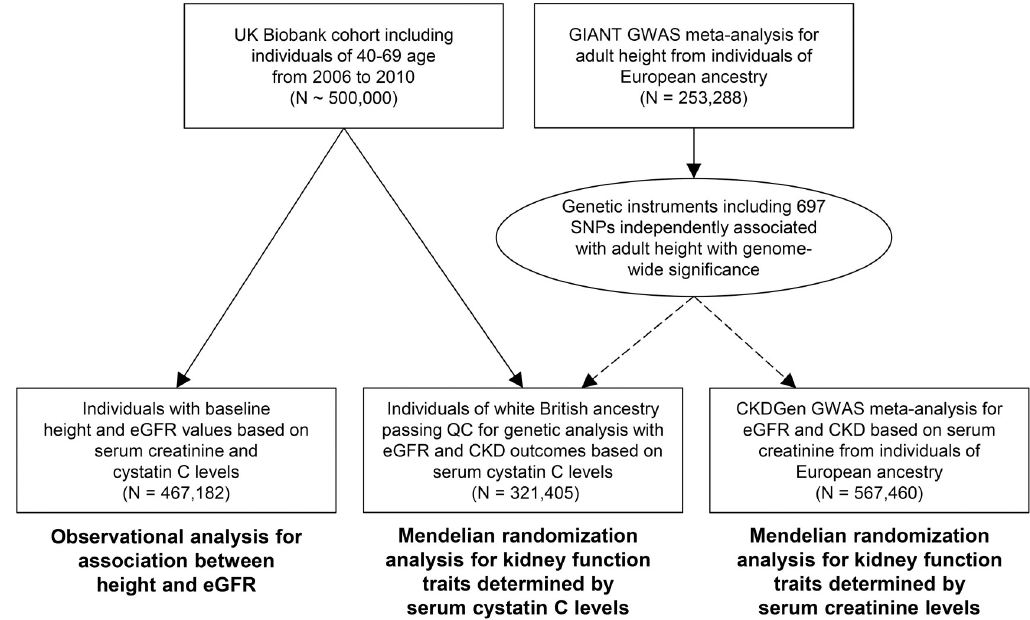
Fig 1. Study flow diagram. CKD = chronic kidney disease, eGFR = estimated glomerular filtration rate, GWAS = genome-wide association study, SNP = single-nucleotide polymorphism, QC = quality control, MR = Mendelian randomization.